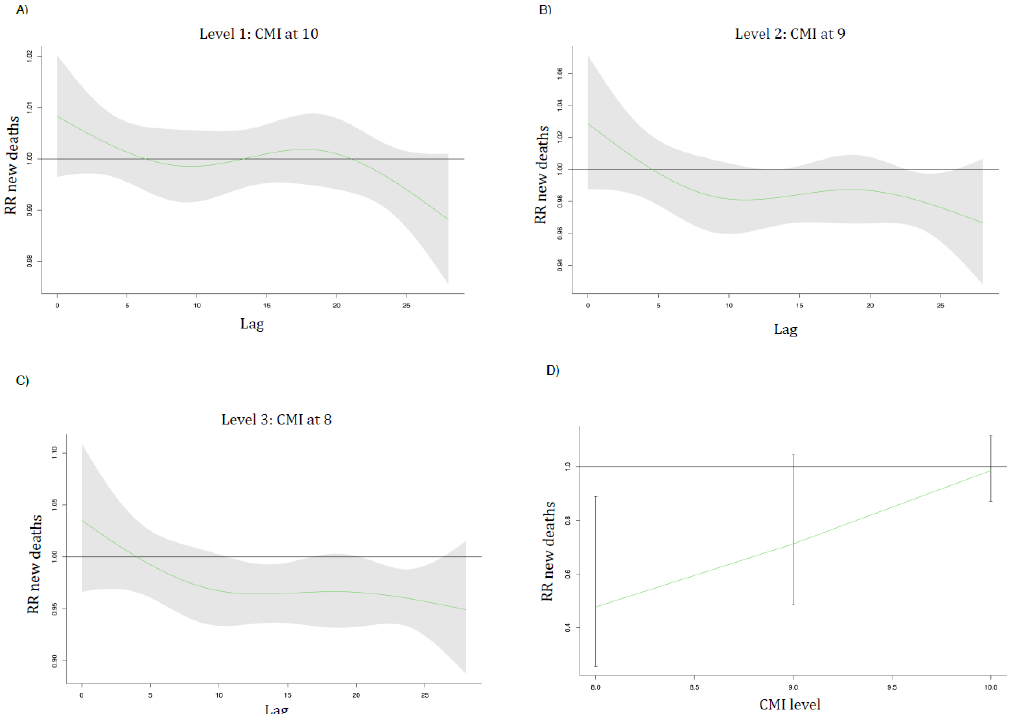
Figure 4. The lag curves (in days) representing the RR of COVID-19 mortality with a shaded 95% CI for each future day following a decrease in CMI at level 1 (A), level 2 (B), and level 3 (C). (D) represents the overall reduction in deaths with each level of CMI. Level 1 is CMI = 10, level 2 is CMI = 9, and level 3 is CMI = 8.